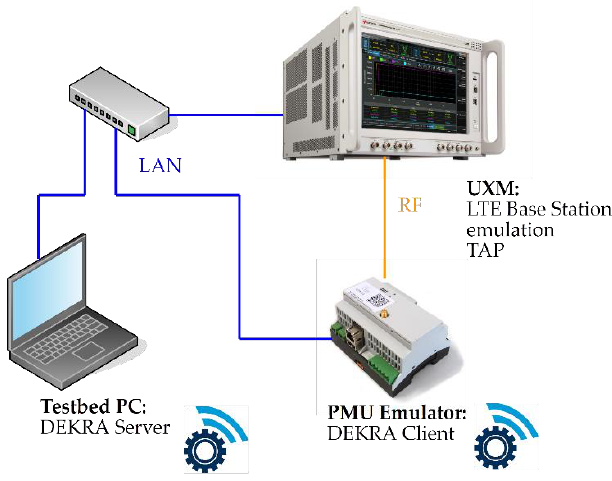
Figure 1. IEC 61850-90-5 evaluation testbed.